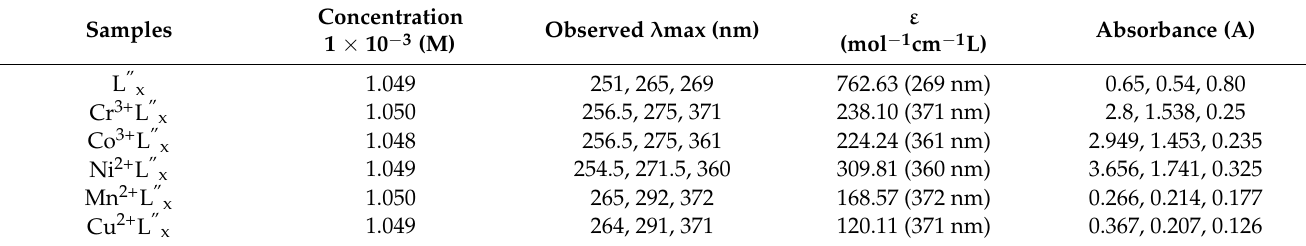
Table 2. Investigated UV-Vis data for the Methyl 2-((4-cyanophenyl)(hydroxy)methyl)acrylate MBH adduct and and its formed